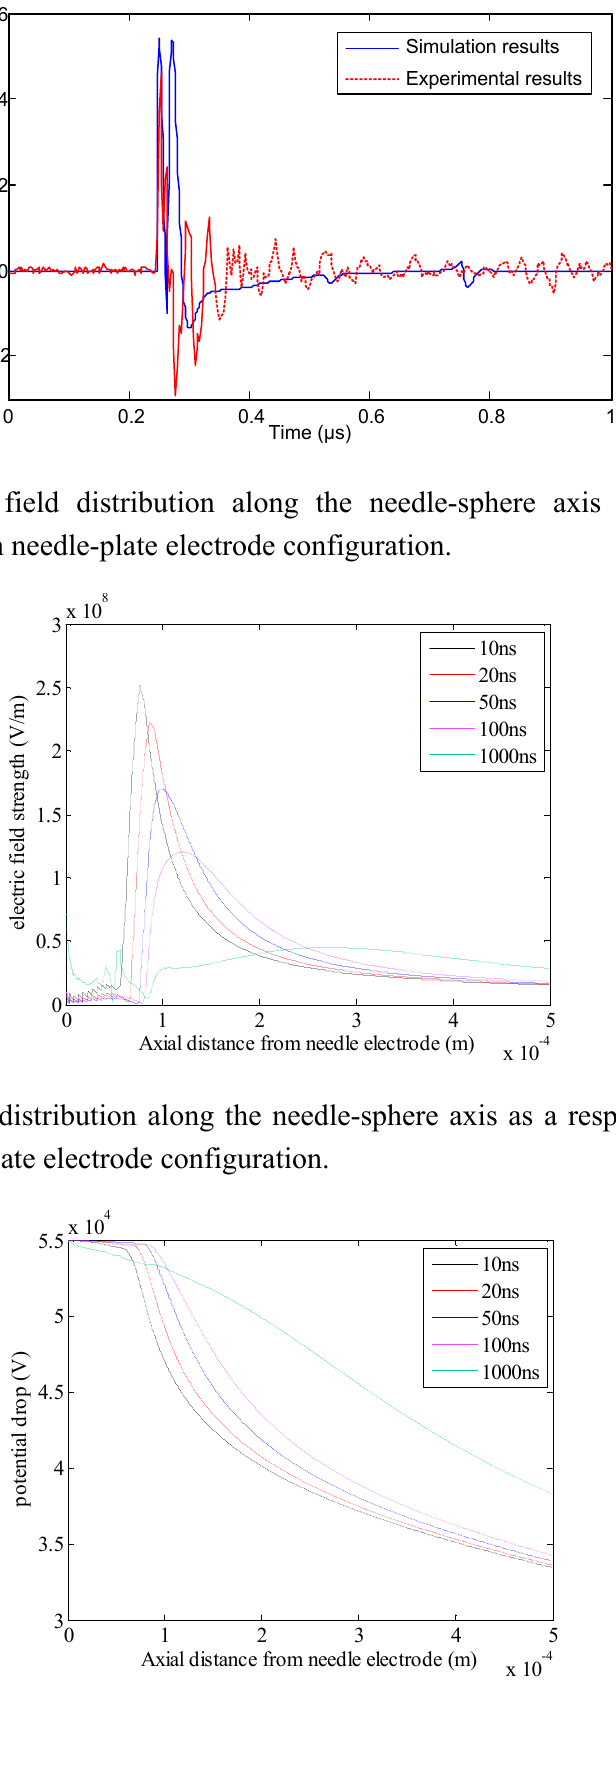
Figure 19. Comparison of the PD current between the simulation and experiment as a response to 1.2 PDIV with 10 mm needle-plate electrode configuration.